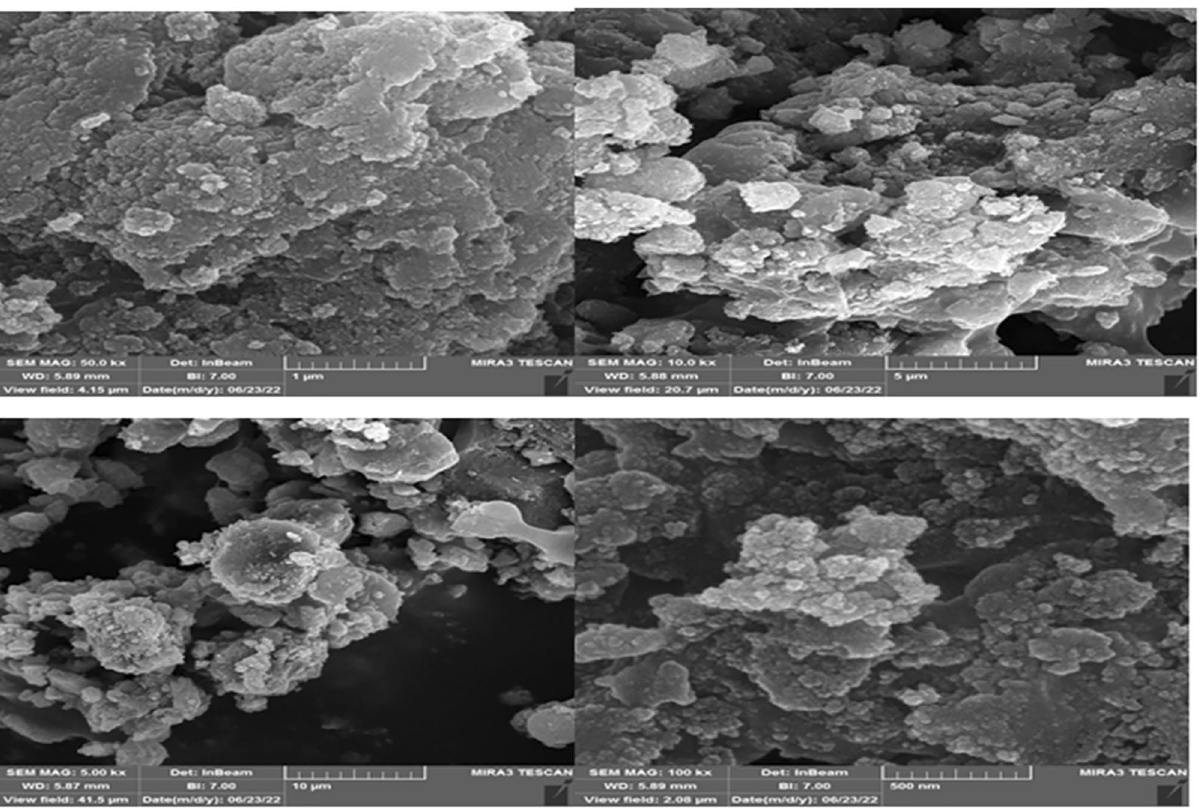
Figure 8. SEM image of synthesized Fe 3 O 4 SEM analysis. Figure 8, shows the morphology and particle size of Fe 3 O 4 @Glycerol-Cu using SEM (scanning electron microscopy). These images indicate the spherical structure and demonstrate that the nanocatalyst was made of uniform nanometer particles. Finally, as can be seen, the nanoparticle size is 18 nm.